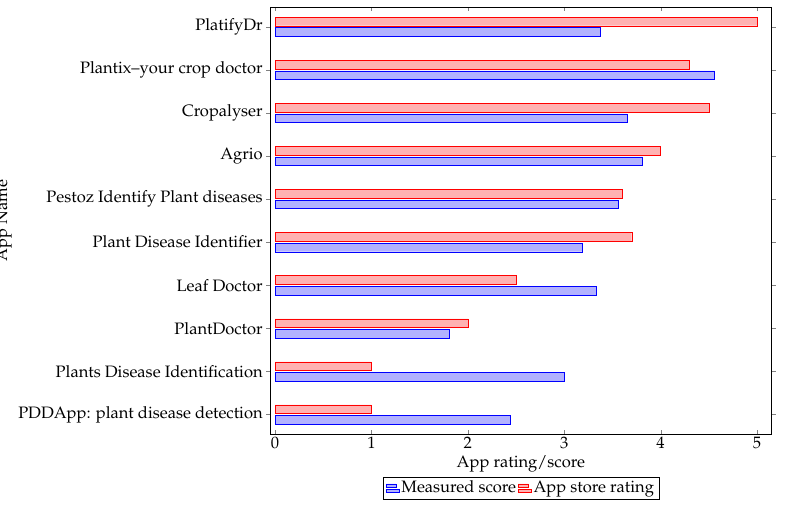
Figure 9. App store ratings (omitted apps those ratings were not available) and measured ratings of the